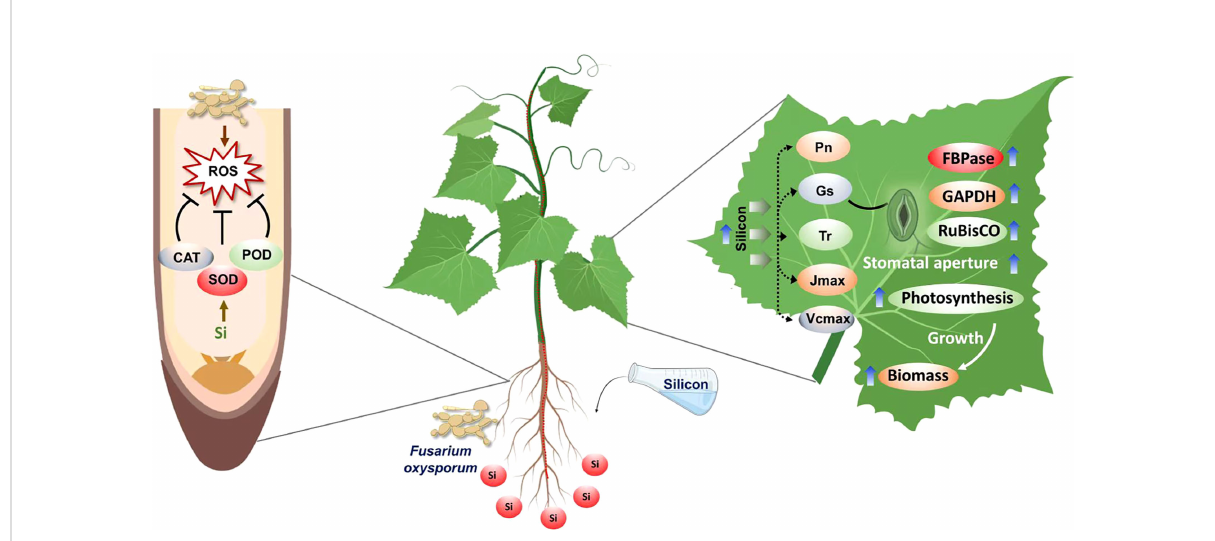
FIGURE 11 A working model depicting the mechanism of silicon-mediated alleviation of Fusarium wilt stress as revealed in the present